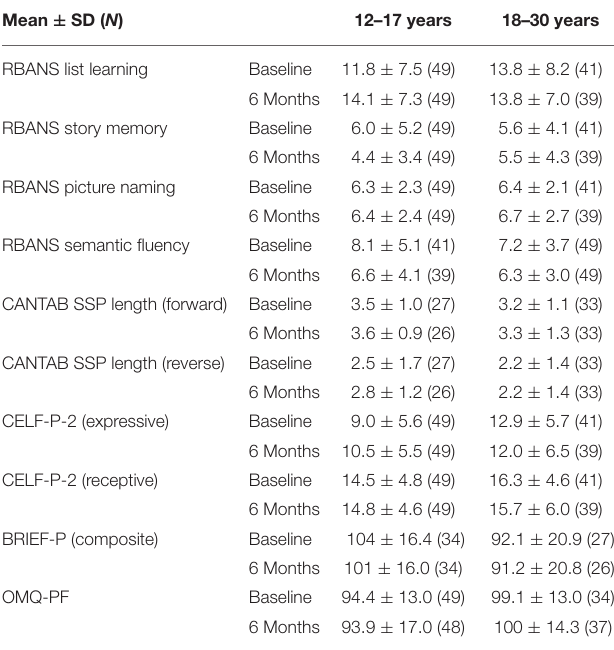
TABLE 4 | Mean scores and standard deviations at baseline and 6 months for each